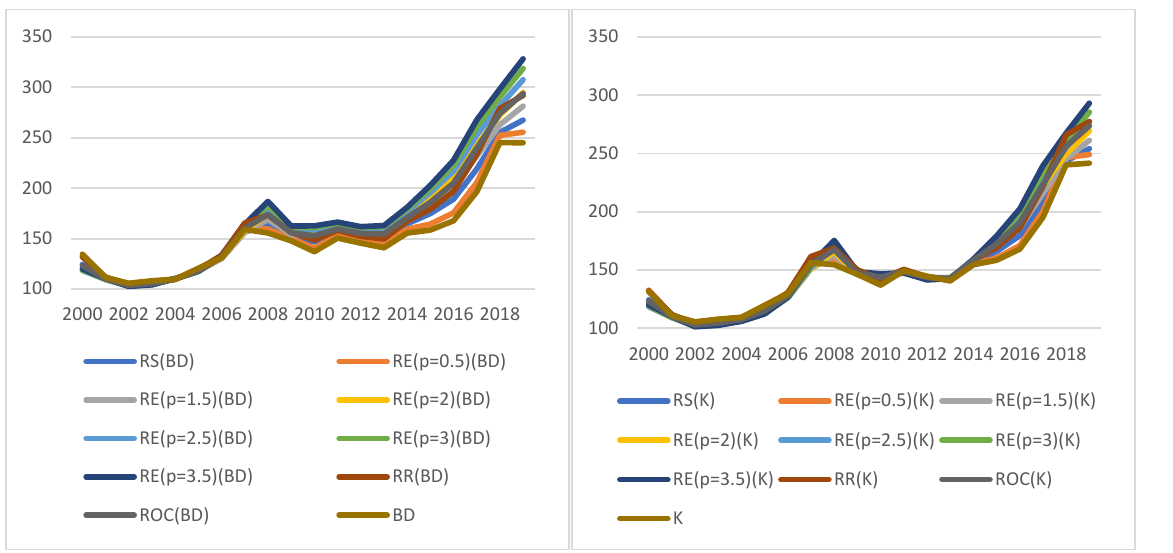
Figure 6. Values of indicators for economic KPI ( 𝐾𝑃𝐼 𝑤𝑜𝑟𝑠𝑡 𝐸 ). Source: authors’ own material based on the GUS data.